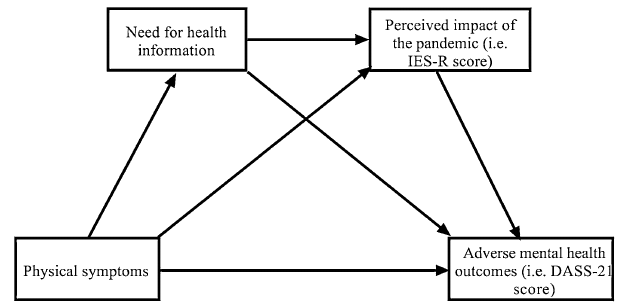
Figure 1. Proposed chain mediation model to explain the association between physical symptoms resembling COVID-19 infection and adverse mental health outcomes (i.e., anxiety, depression and